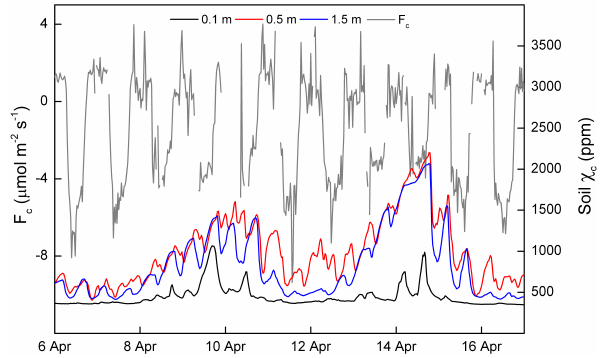
Fig. 4. Average half-hour values at 0.15m (black), 0.5m (red) and 1.5m (blue) depth of soil CO 2 molar fraction ( χ c ) and ecosystem- scale CO 2 fluxes (gray) measured by eddy covariance (F C ; negative values represent uptake). Table 3. Correlation coefficients ( R 2 ) with normalized variables during both the growing period and the dry period (Fig. 2) between soil CO 2 molar fractions ( χ c ) at three depths (0.15, 0.5 and 1.5m), on timescales of 0.5 days and 3 days, versus pressure ( p) and the friction velocity ( u ∗ ) . Growing period Dry period Depth Window